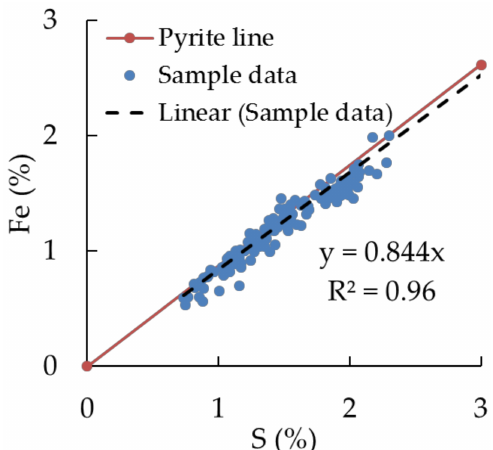
Figure 3. Correlation between Fe and S concentrations in the Eagle Ford Shale (depth ranges from 13,790 ft to 13,825 ft).